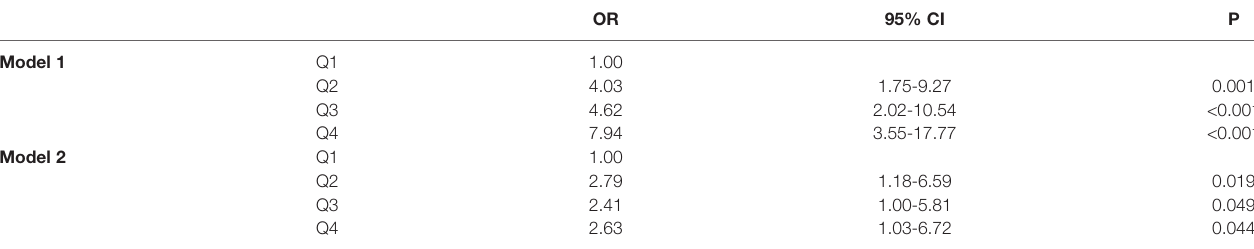
TABLE 3 | Logistic regression analysis to determine the association between SMFI quartiles and